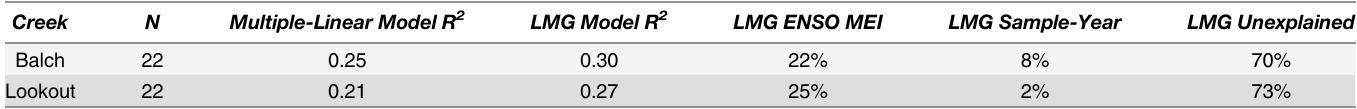
Table 4. Results of the linear model and variance partitioning for the long-term temporal data. R 2 values are shown for both the linear and LMG regression models. Model parameters (ENSO MEI and sample-year) are expressed as percent explained for the LMG and multiple-linear regression models. Creek